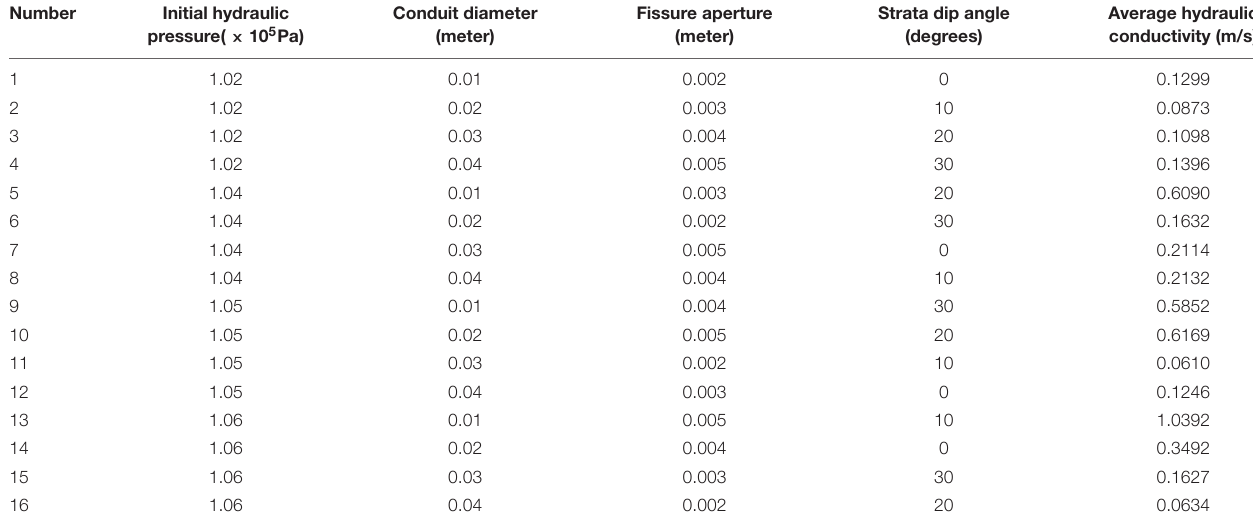
TABLE 3 | The results of 16 group simulation